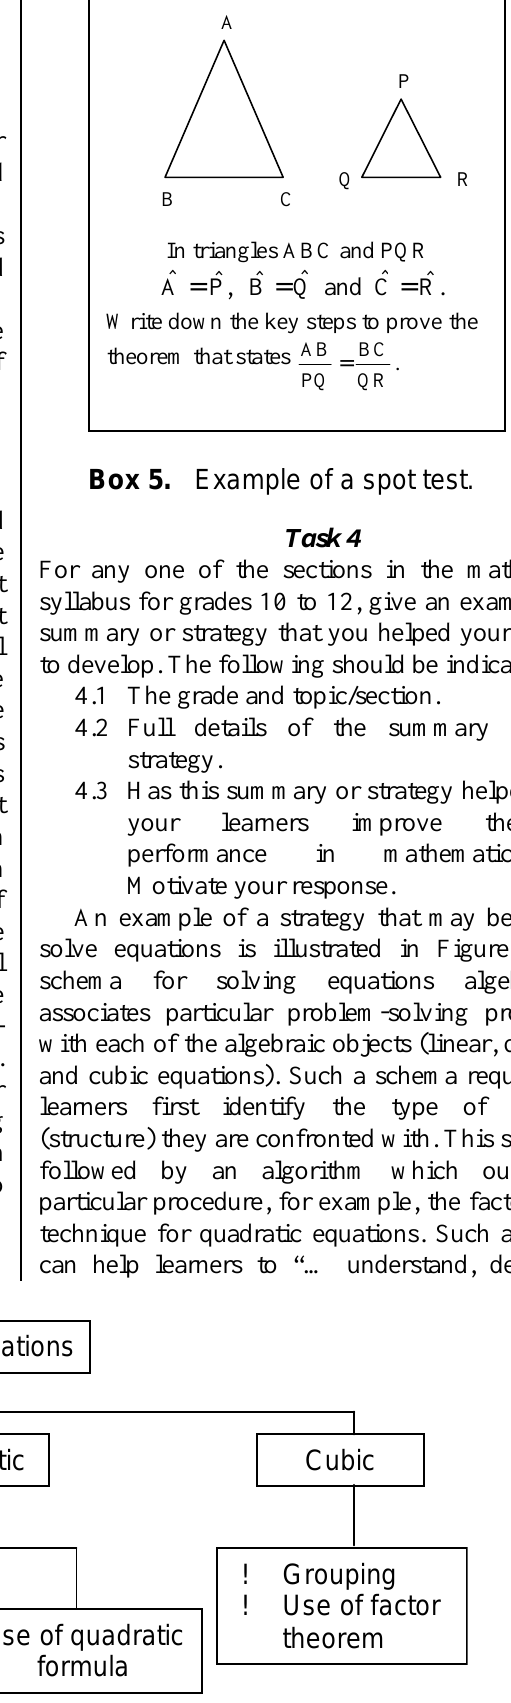
Figure 2. Schema for solving equations